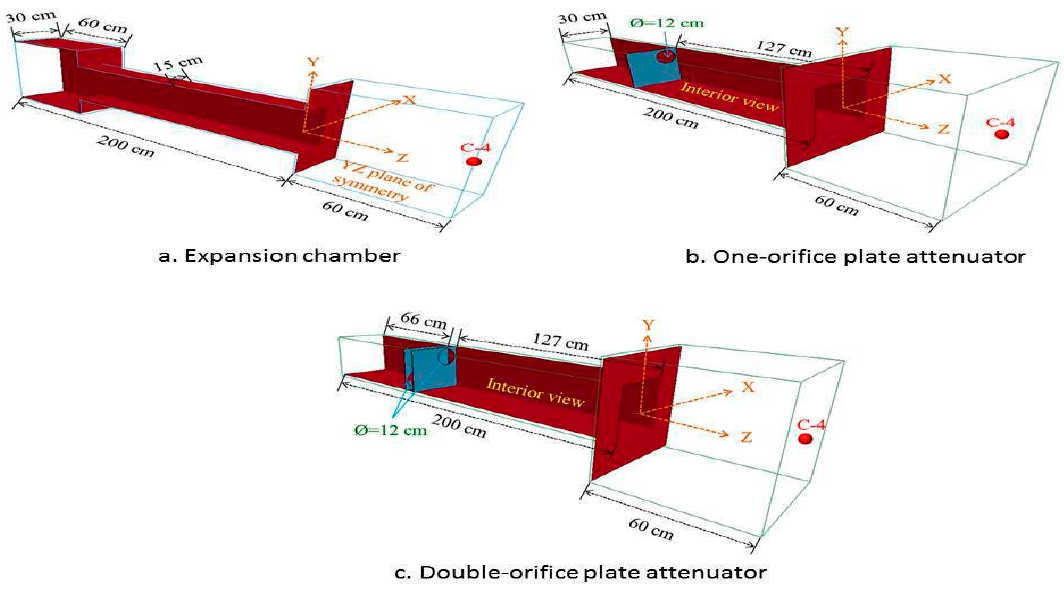
Figure 4. Schematic diagram of numerical models of pressure reduction modules.